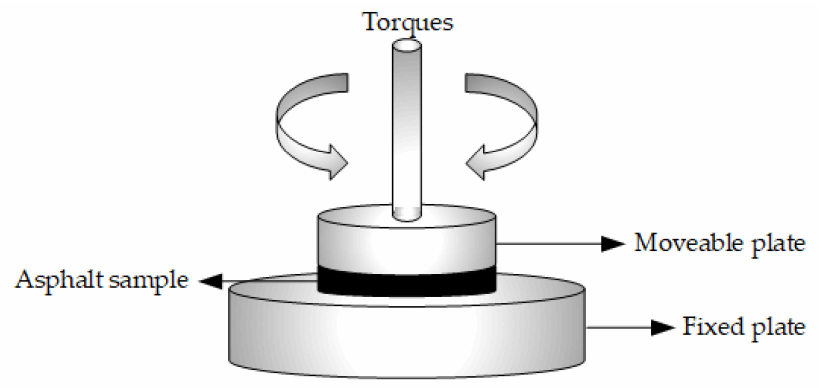
Figure 2. DSR loading method of bituminous sample.